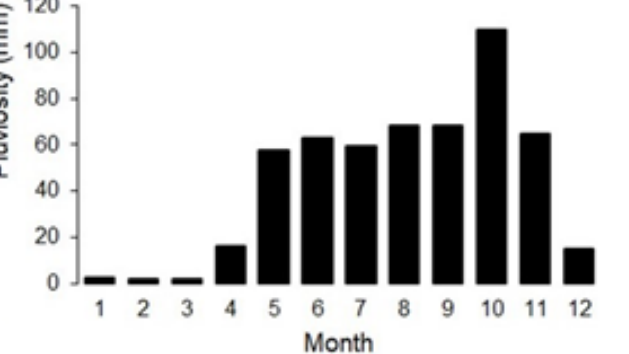
Figure 2. Average of rainfall regime by season in Santa Marta between the years of 2015 and 2017. Source: Instituto de Hidrología, Meteorología y Estudios Ambientales (IDEAM).